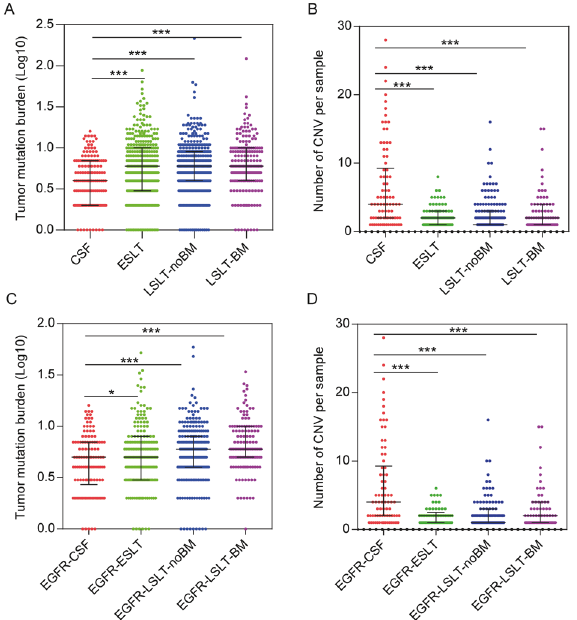
Fig. 1 Summary of TMB and CNV count differences across the CSF and other primary lung tissue samples. A , B Show the difference of TMB and CNV between CSF and ESLT, LSLT-noBM, LSLT-BM groups, respectively. C , D Show the difference of TMB and CNV in EGFR -CSF and EGFR -ESLT, EGFR -LSLT-noBM, EGFR -LSLT-BM subgroups, respec- tively. Statistical analysis was performed using the Mann – Whitney test. * P < 0.05, *** P <